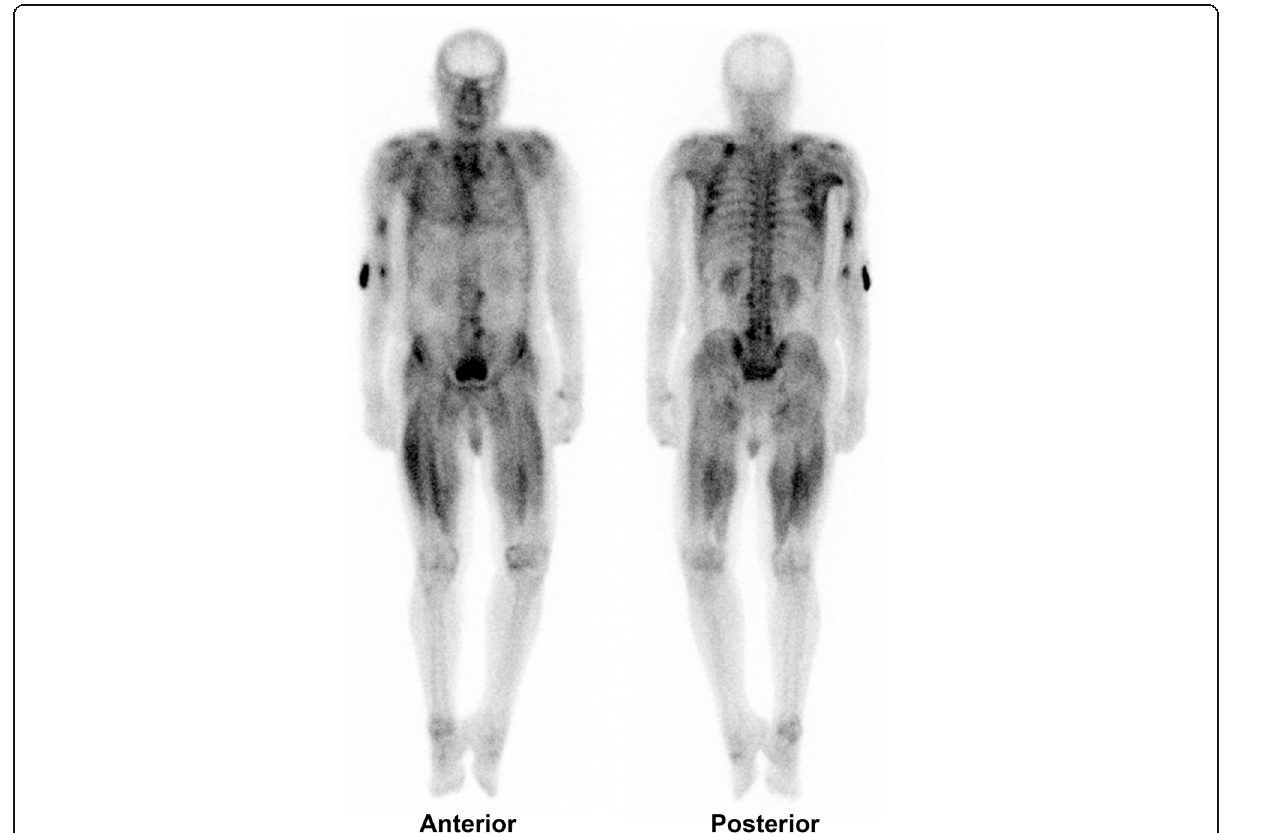
Fig. 1 99m Tc-MDP planar bone scintigraphy showing diffuse intense uptake at the soft tissue of bilateral shoulder region, upper thoracic and proximal thighs. A focus of increased tracer uptake in the mid shaft of the right humerus is contributed to a healing fracture caused by previous